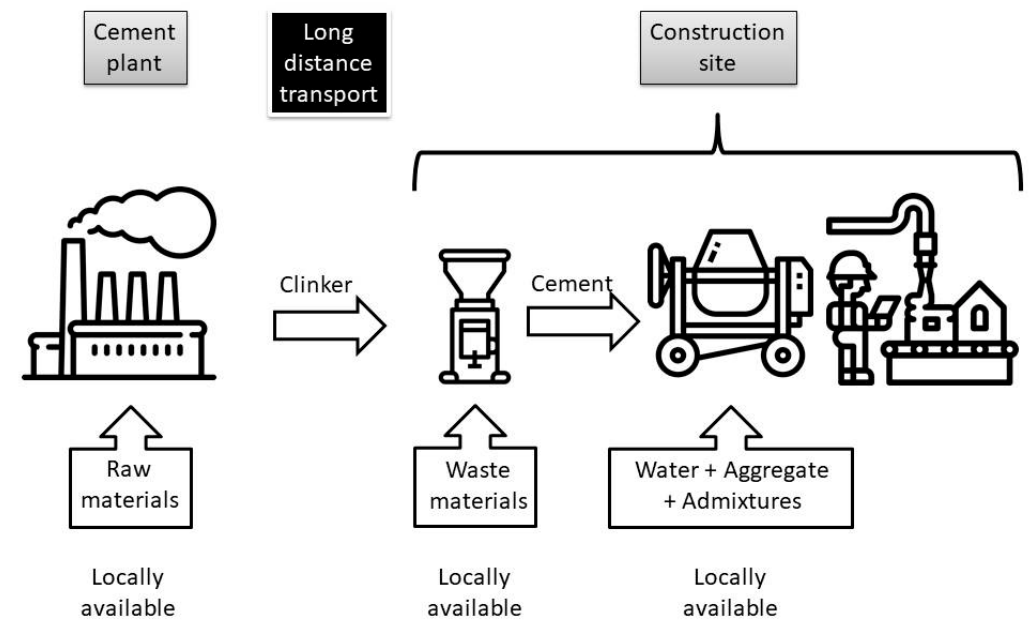
Figure 2. Postulated cycle of materials circulation during cement and concrete production (see Acknowledgments).